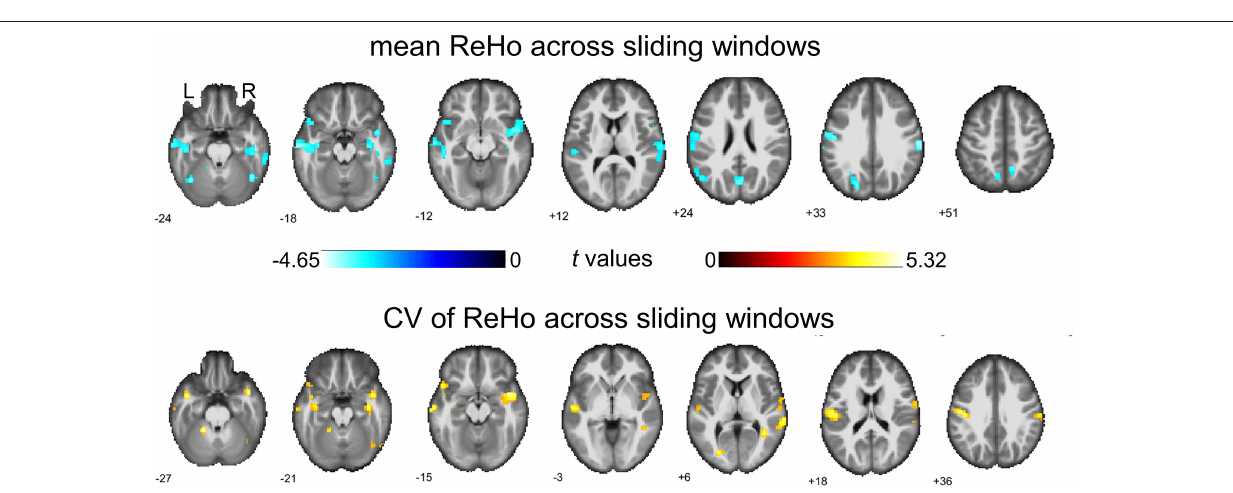
FIGURE 3 | Between-group comparisons of mean ReHo and coefficient of variation (CV) of ReHo across sliding windows (with global signal regression). Both significant decreased mean ReHo (top row) and increased CV of ReHo (bottom row) were found in the right insula gyrus (INS.R), right fusiform gyrus (FFG.R), left postcentral gyrus (POG.L), left middle temporal gyrus (MTG.L), right rolandic operculum/superior temporal gyrus and part of the right cerebellum (lobule Crus1). The warm color represents increases and the cold color represents decreases when comparing children with BECTS with HCs. These results were voxel-wise p < 0.001, cluster level p < 0.05, family-wise error (FWE) cluster-level corrected, and minimum cluster > 20